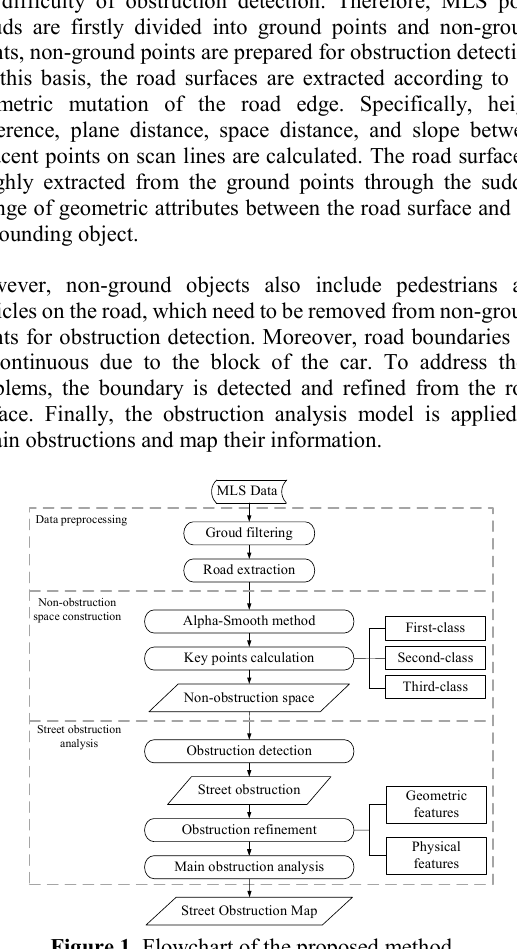
Figure 1 . Flowchart of the proposed